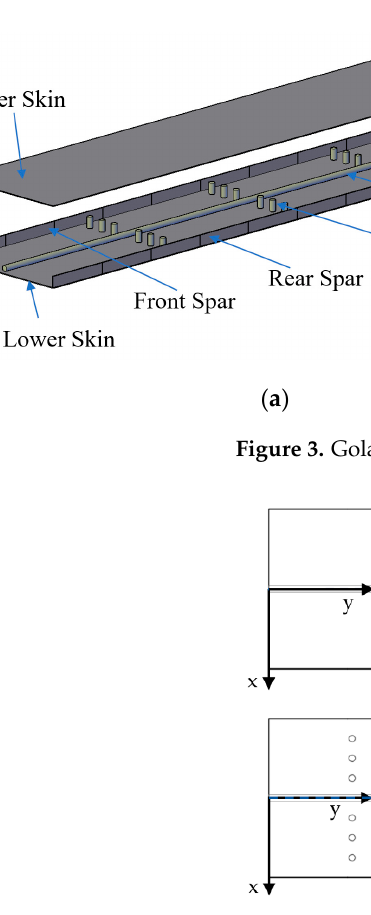
Figure 4. Skeletal rods positions in x-y plan for Goland wing modifications in Case. I and Case. II.